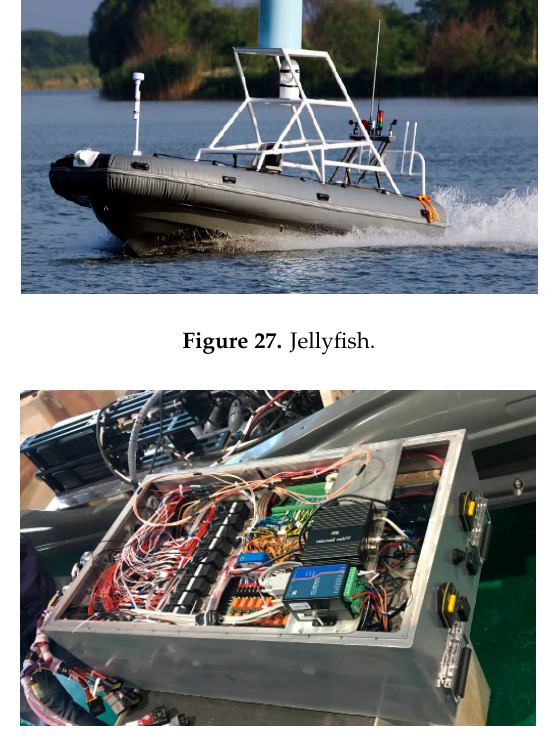
Figure 28. Hardware composition of USV cruising control system.